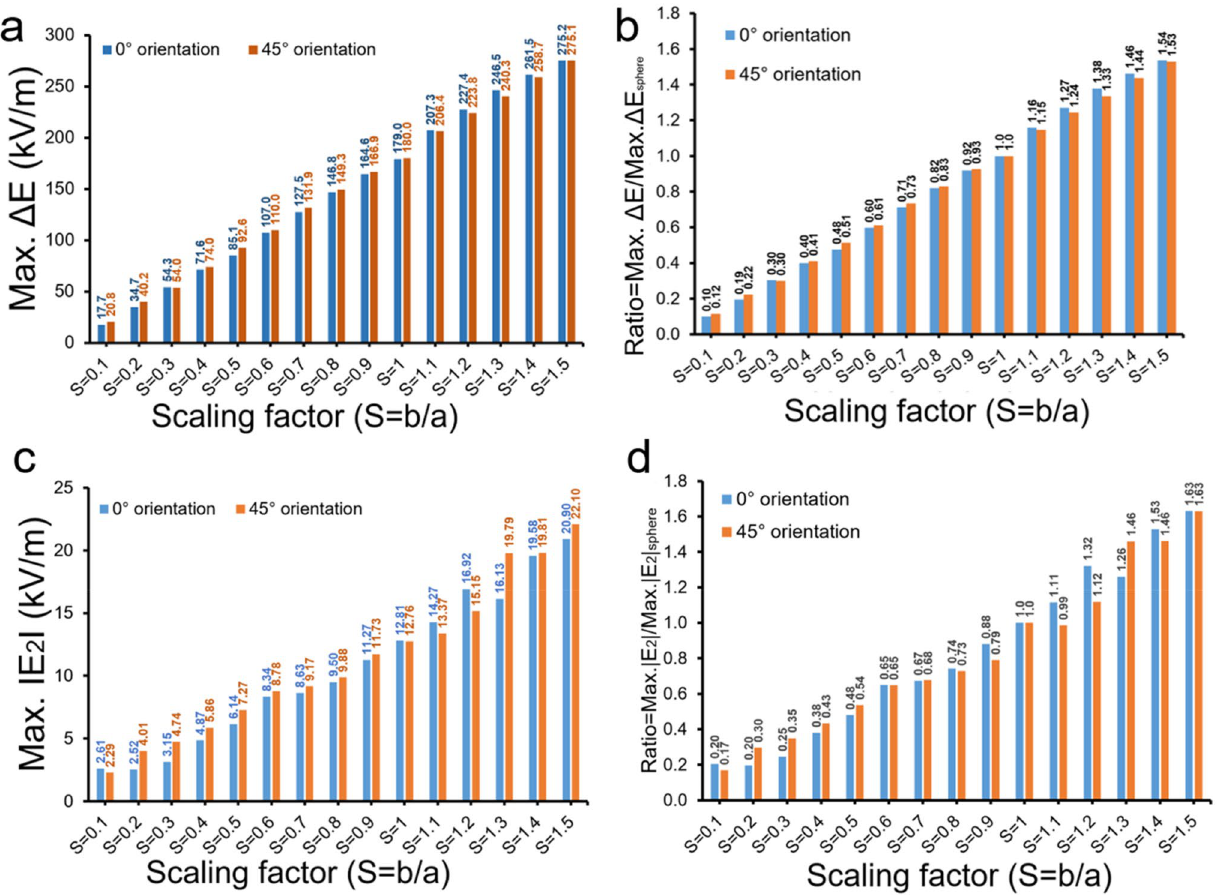
Figure 6. Comparison of spherical and non-spherical particle signal variation with respect to orientation (0-degree and 45-degree) within integrated design IE-1. ( a ) Maximum of ΔE with respect to scaling factor at two different orientations of particle position, ( b ) Comparison of ration of maximum value of ΔE of non- spherical particle (S = 0.1 to 1.5) to spherical particle for both orientations, ( c , d ) Comparsion of maximum |E 2 | signal and |E 2 | ratio at different sacling factors for both